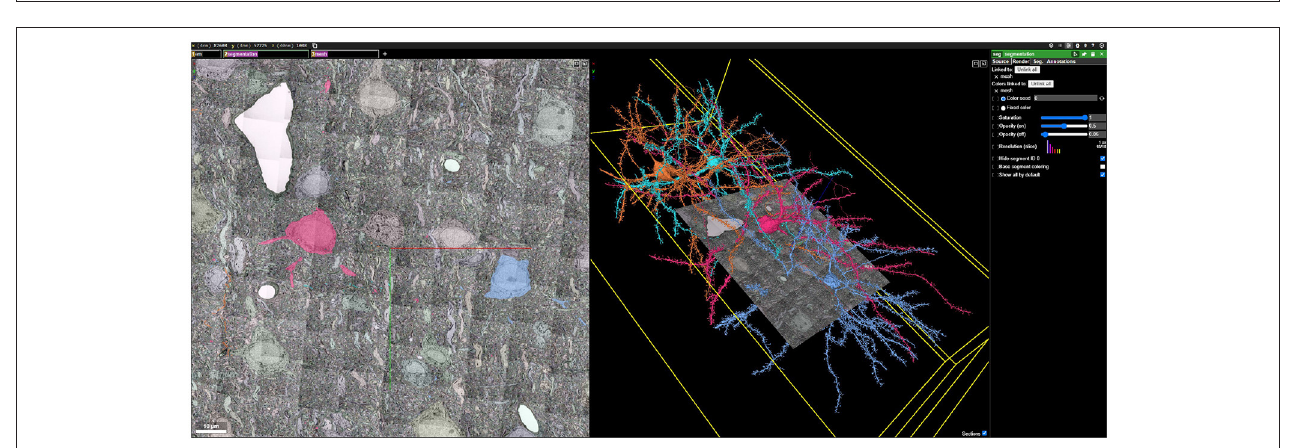
FIGURE 11 | A CloudWatch dashboard monitoring during ingestion.